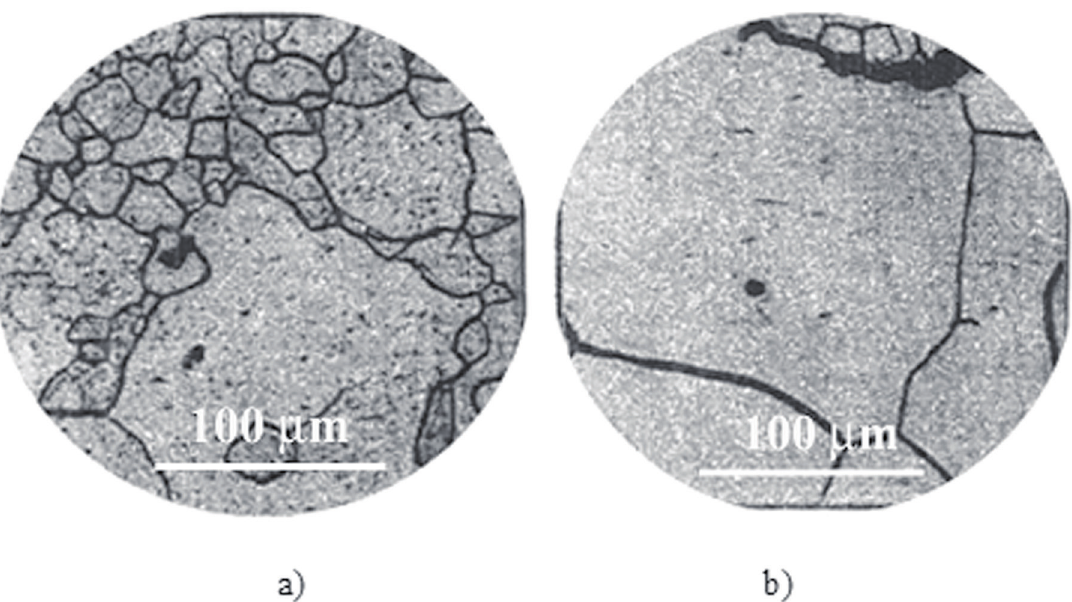
Figure 3: Microstructure of sample composition PtRh20Pd10Ir0.1Au0.1 with impurities content of 0.0286%: a) before and b) after creep, at 1400 °C and a stress of 5MPa, close to the rupture point (magnification